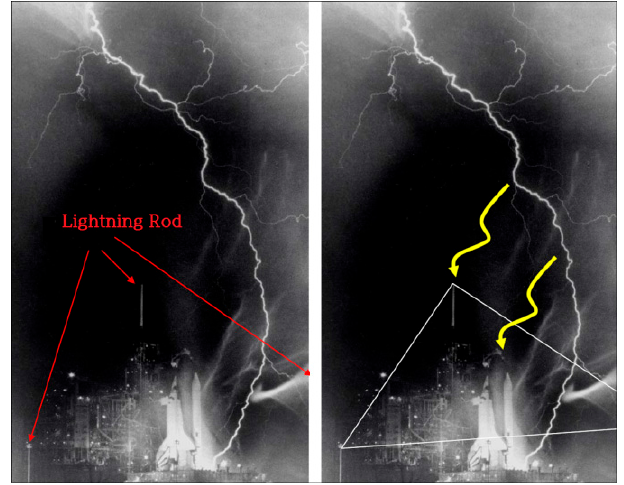
Figure 7. Installation of lightning rods and their problem.